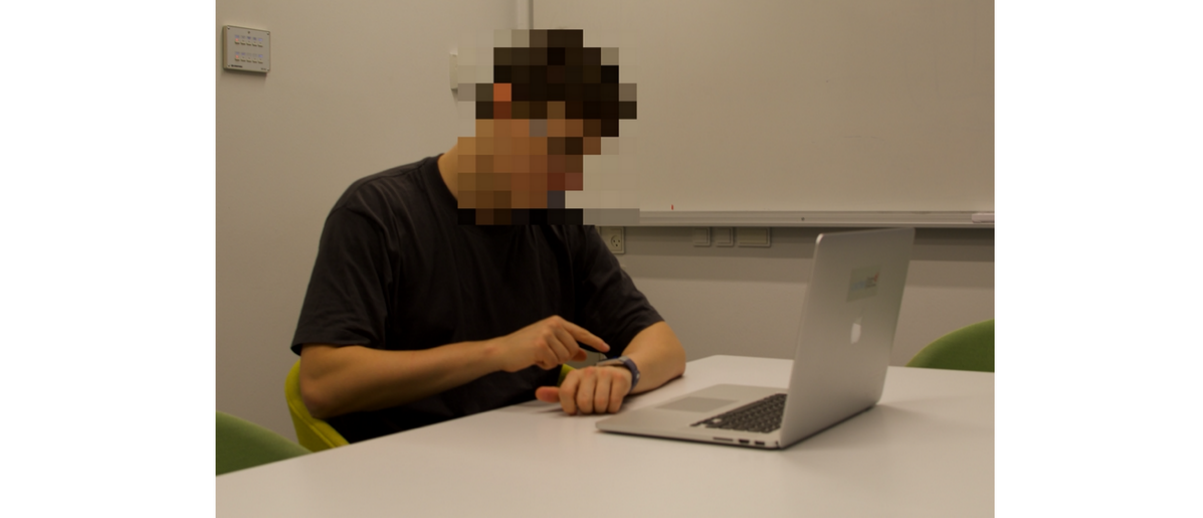
Figure 4. A study participant completing a UbiCAT (Ubiquitous Cognitive Assessment Tool) test via a Fitbit Ionic smartwatch. The laptop was used to administer computer-based